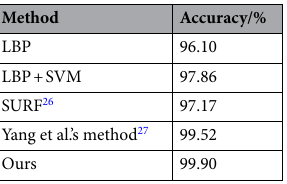
Table 4. Experimental results of traditional algorithms.